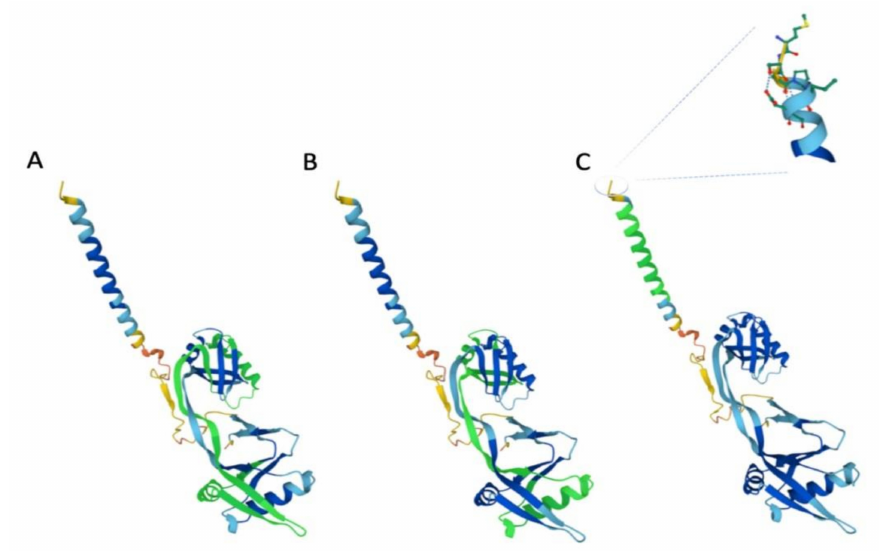
Figure 1. The tertiary structure of IFP35. Note, in green, respectively NID1 ( A ), NID2 ( B ), and leucine zipper motif ( C ). In C, also the N-terminus with its amino acid residues is represented in an exposed manner. (Figure reproduced from https://www.uniprot.org/uniprot/P80217/protvista, accessed on 7 September